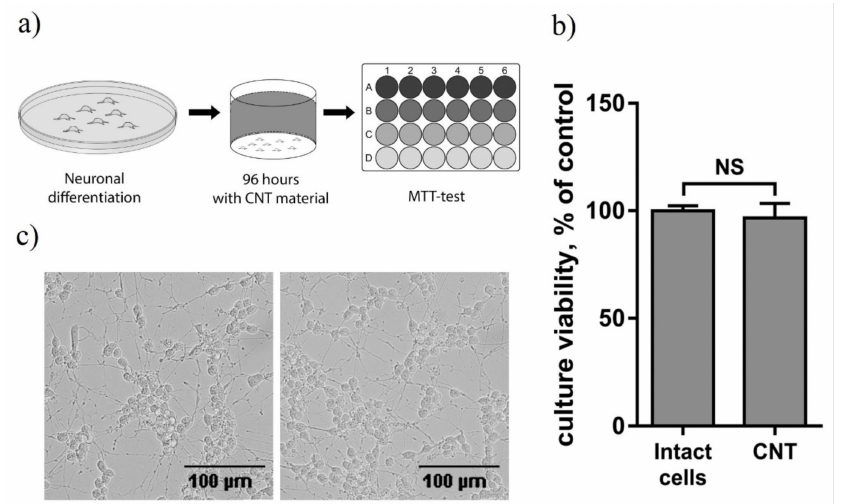
Figure 6. Evaluation of the CNT/G/PDMS biocompatibility on the differentiated human neurob- lastoma SH-SY5Y cell line: ( a ) the experimental design; ( b ) comparison of the culture viability of the control cells and those incubated with CNT/G/PDMS cells, n = 8; ( c ) microphotographs of the control cells and those incubated with CNT/G/PDMS